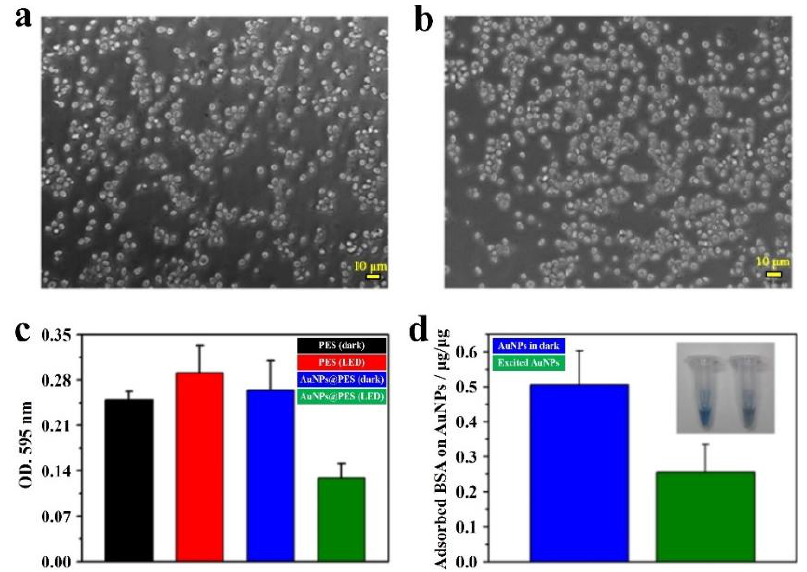
Figure 10. The cytocompatibility and hemocompatibility of excited AuNPs@PES membranes. Microscopic images of the RAW 264.7 macrophage cell line growing on ( a ) a blank plate in the dark and ( b ) an excited AuNPs@PES membrane for 4 h. ( c ) Tests of protein adsorption based on BSA. ( d ) Adsorption of BSA onto AuNPs under resonant illumination and in the dark ( n = 3). Inset: Images of AuNP-containing solutions under resonant illumination ( right ) and in the dark ( left ). The precipitated AuNPs were dispersed in Bio-Rad Protein Assay solutions after shaking a mixed solution of AuNPs and BSA for 1 h [73].